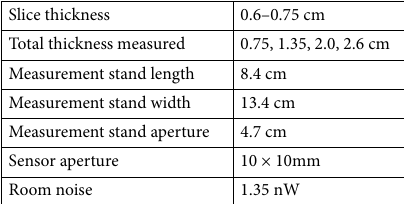
Table 1. Essential information about the